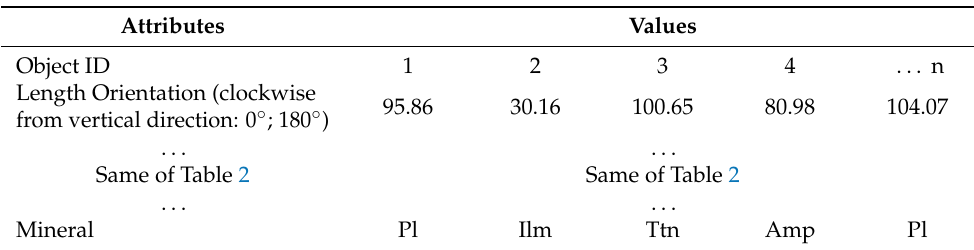
Table 3. Example of the dataset of mineral grain size descriptors and mineral shape factors derived from the Min-GSD